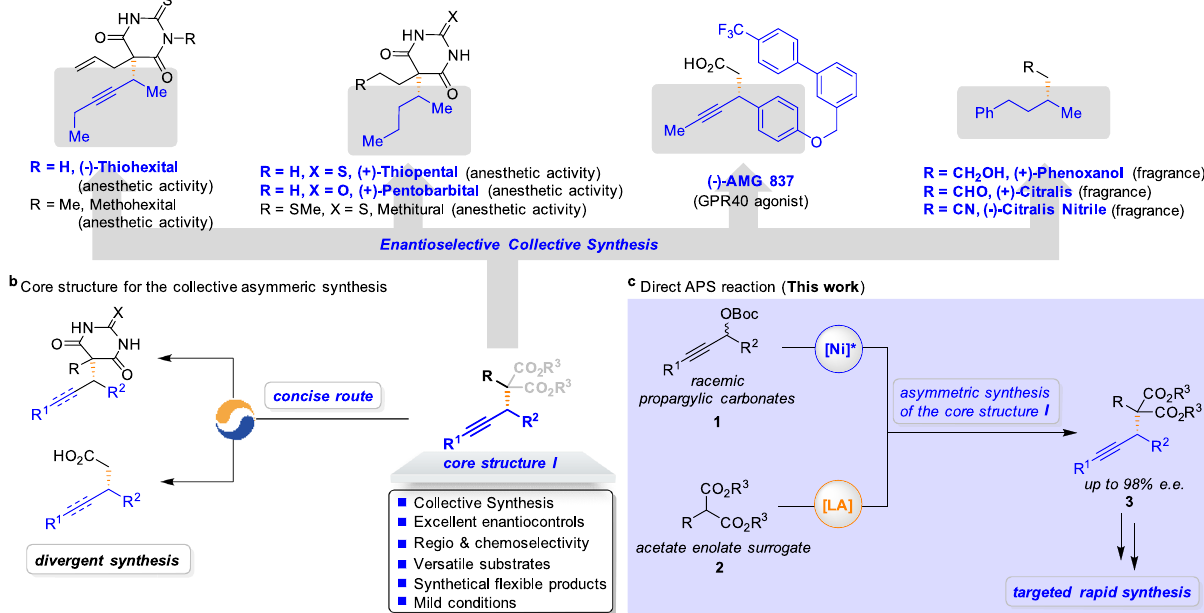
Fig. 1 Design of the APS reactions for the collective synthesis of seven biological active molecules. a Enantioselective collective synthesis of ( − )-Thiohexital, ( + )-Thiopental, ( + )-Pentobarbital, ( − )-AMG 837, ( + )-Phenoxanol, ( + )-Citralis, and ( − )-Citralis Nitrile. b Core structure I for the enantioselective collective synthesis. c Realization of the Ni/Lewis acid-catalyzed the APS reaction of malonates to enhance the pace of drug discovery and development (this